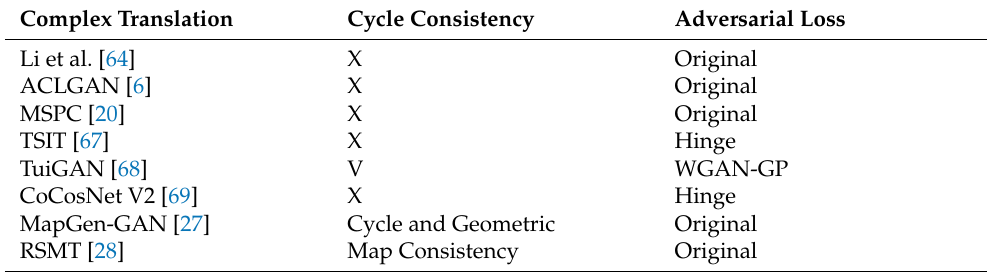
Table 5. Comparison between papers in the Complex Translation category. For this category (Section 6), the comparison was performed based on the cycle consistency utilization and the type of adversarial loss involved. “V” and “X” means that the method use the technique in the columns is “used” and “not used” respectively. “-” indicates that the corresponding information was not found.